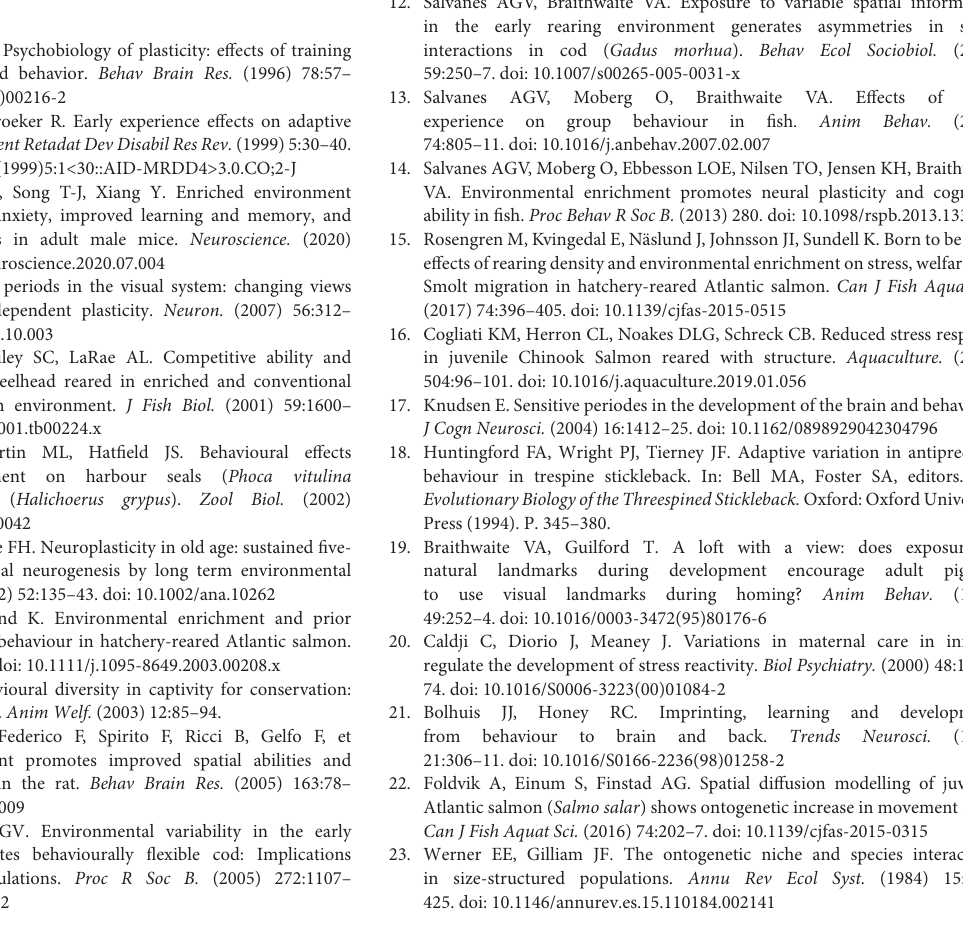
Supplementary Figure 1 | Comparisons of control and enriched reared juvenile Atlantic salmon ( Salmo salar ). The lines show cumulative values at the individual level over seven days of testing, where grey and black lines represent control and enriched reared fish, respectively. Time to leave start box of (a) 18-week old fry and (b) 31-week old parr. Number of chamber changes of (c) 18-week old fry and (d) 31-week old parr. Time spent freezing of (e) 18-week old fry and (f) 31-week old parr. Open and solid circles represent mean values for control and enriched reared fish,